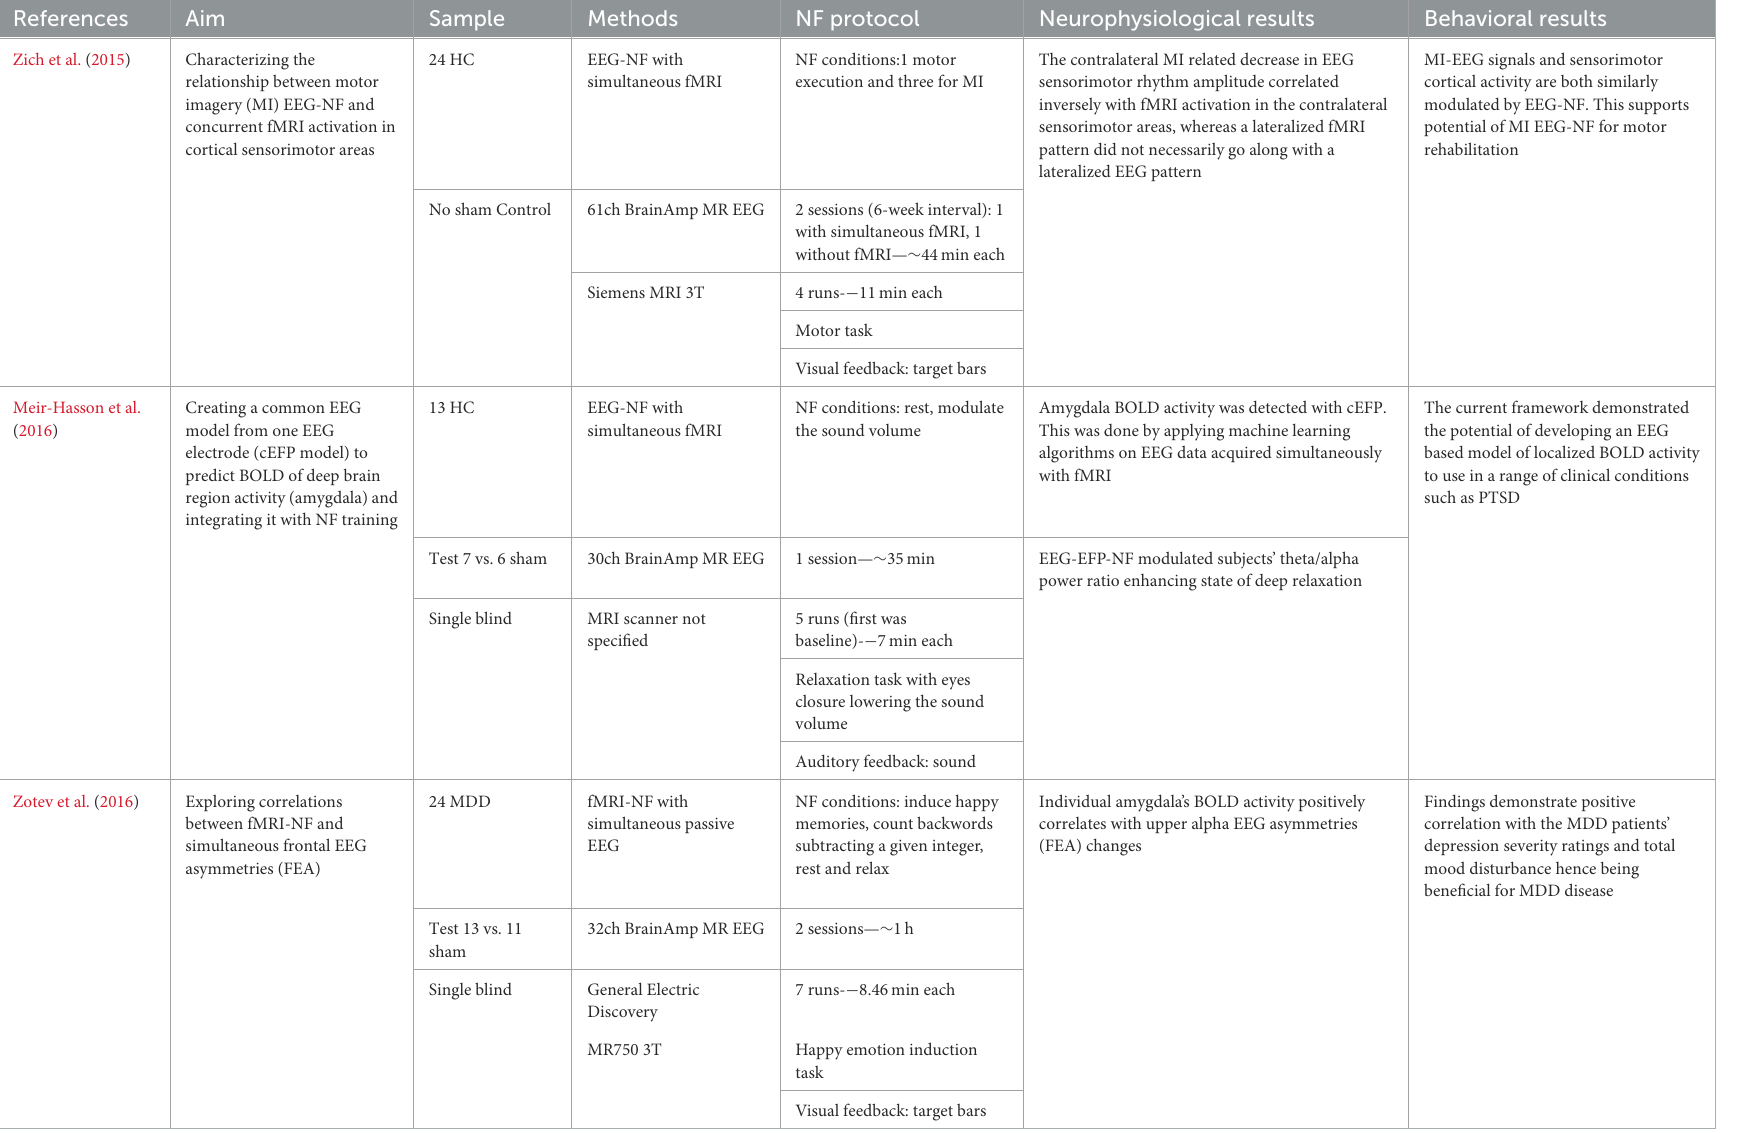
TABLE 2 Seven unimodal studies (EEG-NF with simultaneous fMRI-NF or vice versa) included in the review organized by: authors, aim of the study, sample, methods, NF protocol, neurophysiological results, and behavioral